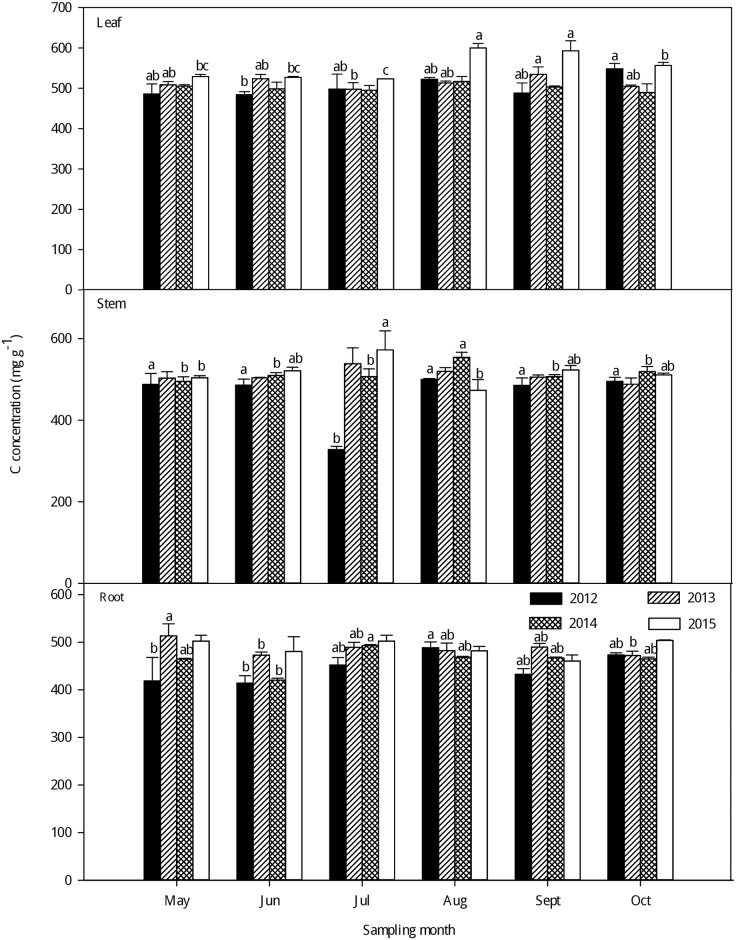
Seasonal variations in the C concentrations (mean ± SE) in different organs of larch stands from 2012–2015.Different lowercase letters represent significant differences among different growing seasons at P < 0.05.